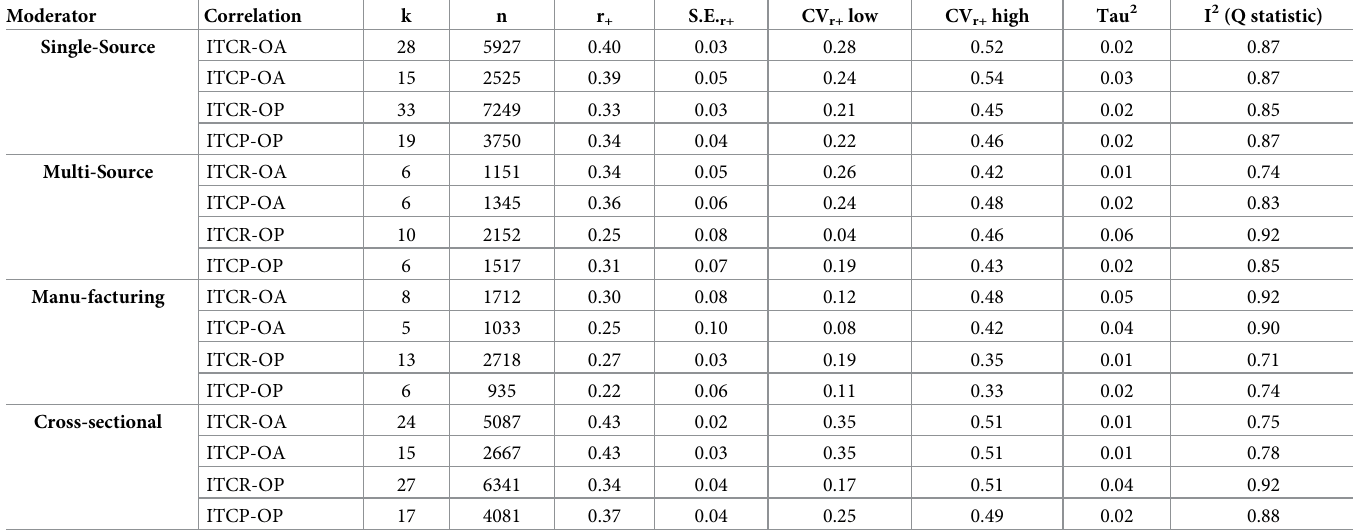
Table 5. Overview of meta-correlations by